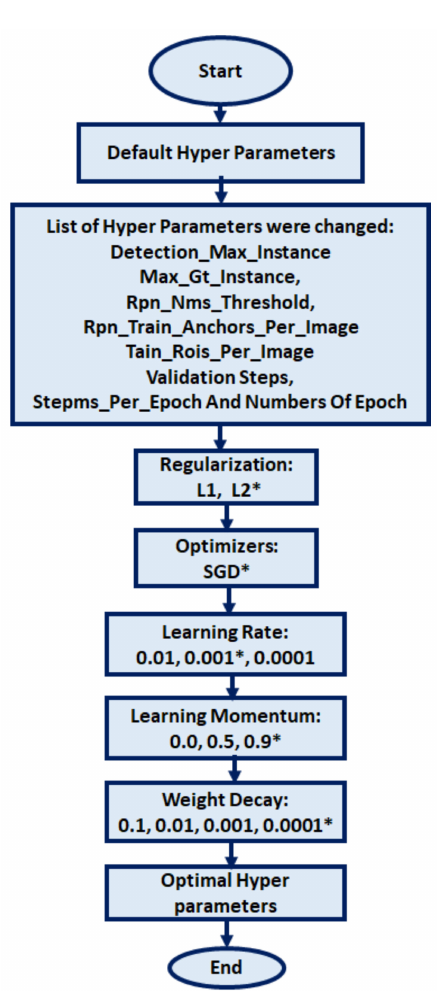
Figure 7. The process of finding the optimal